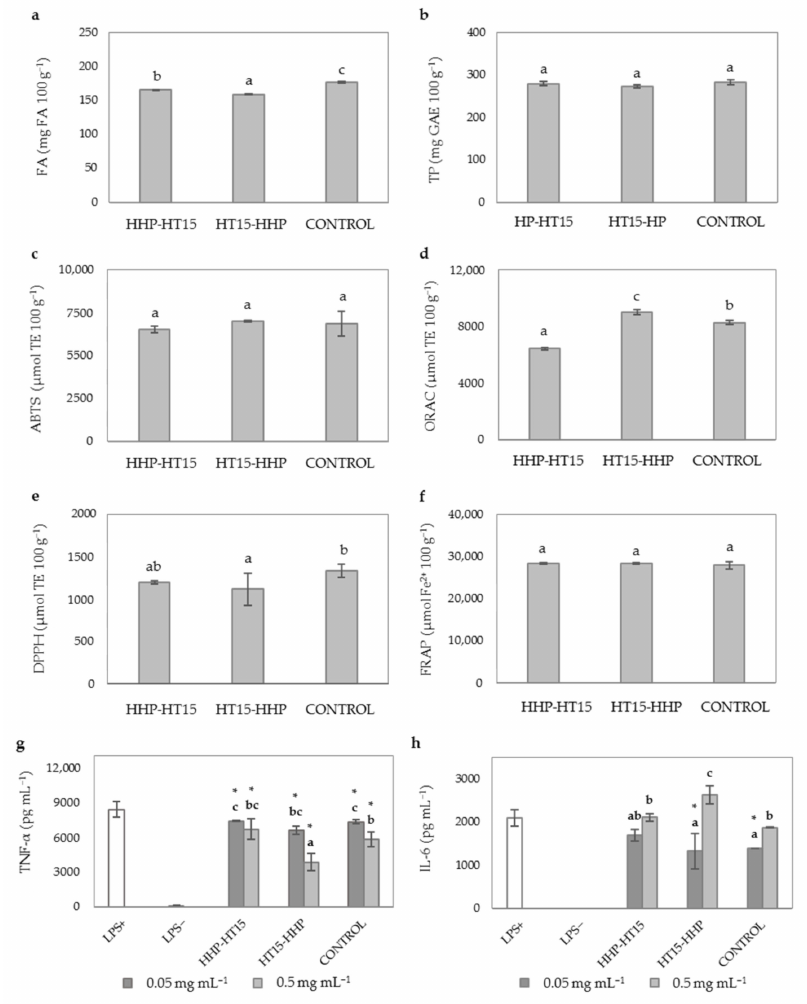
Figure 3. Evaluation of the sequential use of HT and HHP on phenolic compounds content, TAC and AIA of WB hydrolysates. ( a ) FA content (mg 100 g − 1 ); ( b ) TP content (mg GAE 100 g − 1 ); ( c ) ABTS scavenging activity ( µ mol TE 100 g − 1 ); ( d ) ORAC ( µ mol TE 100 g − 1 ); ( e ) DPPH scavenging activity ( µ mol TE 100 g − 1 ); ( f ) FRAP ( µ mol Fe 2+ 100 g − 1 ); ( g ) TNF- α levels (pg mL − 1 ); ( h ) IL-6 levels (pg mL − 1 ). Sample identification: hydrothermal treatment for 15 min (CONTROL), HHP followed by HT for 15 min (HHP-HT15), and HT for 15 min followed by HHP (HT15-HHP). Different lowercase letters show significant differences between different treatment groups (one-way ANOVA, post hoc